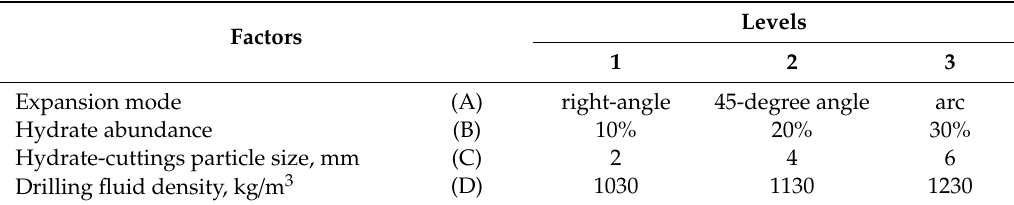
Table 1. Factors influencing and levels of rock carrying